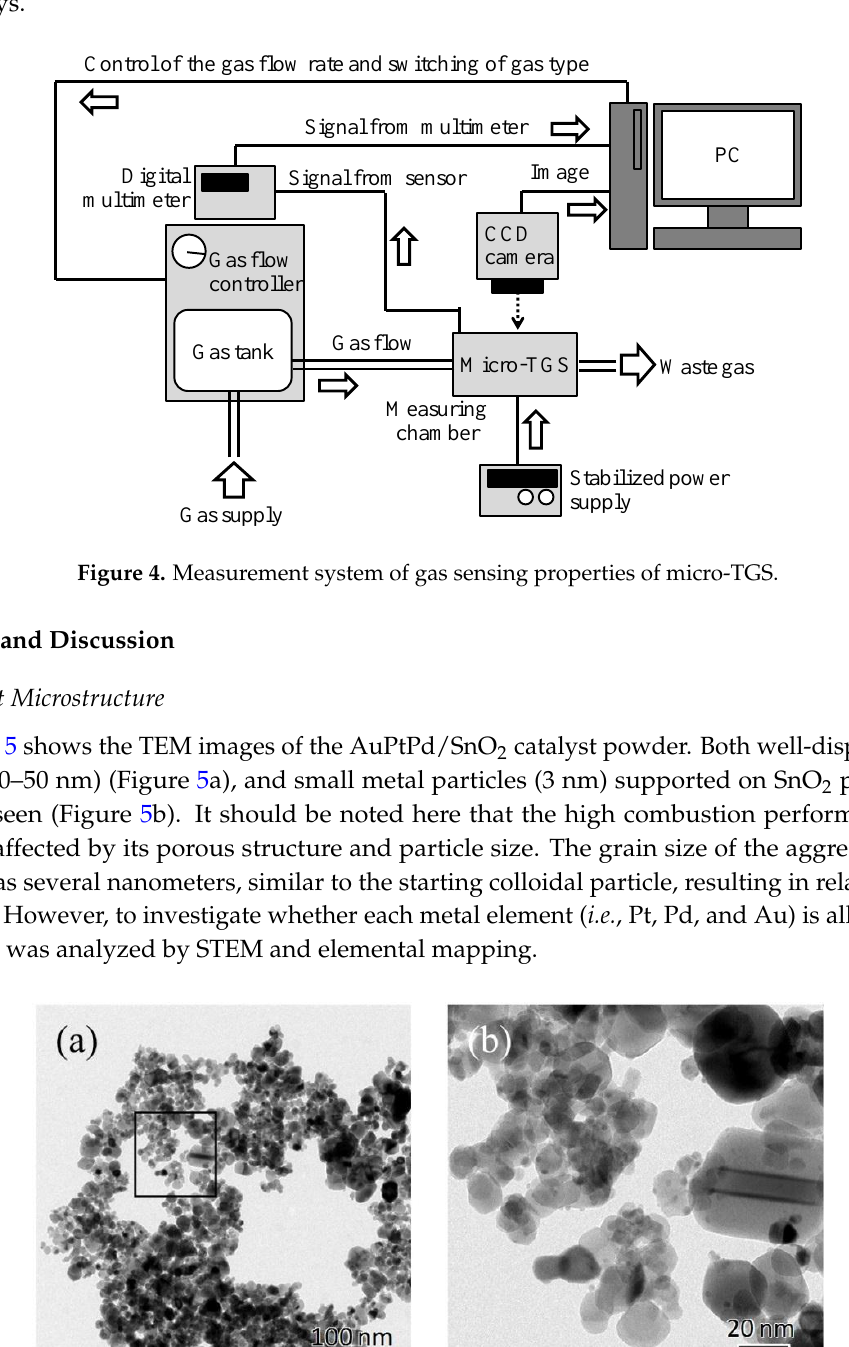
Figure 5. Transmission electron microscopy (TEM) images of the AuPtPd/SnO 2 catalyst powder: ( a ) low magnification (17,500) and ( b ) high magnification (88,000).